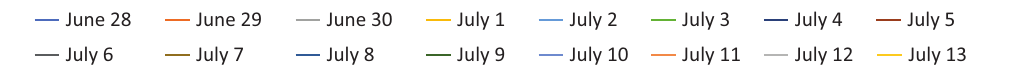
Figure 11. Number of transactions according to the days of the Festival. weekends and weekdays. The two curves also follow equivalent trends. Compared to the previous analysis, an important contrast is observed. The increase in at- tendance appears less sudden than in the first analysis.